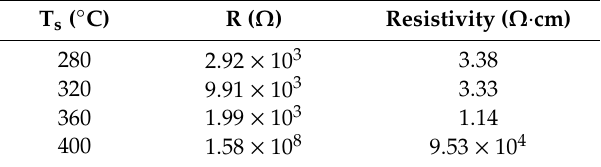
Table 3. Electrical resistivity of the CMTS thin films deposited at di ff erent substrate